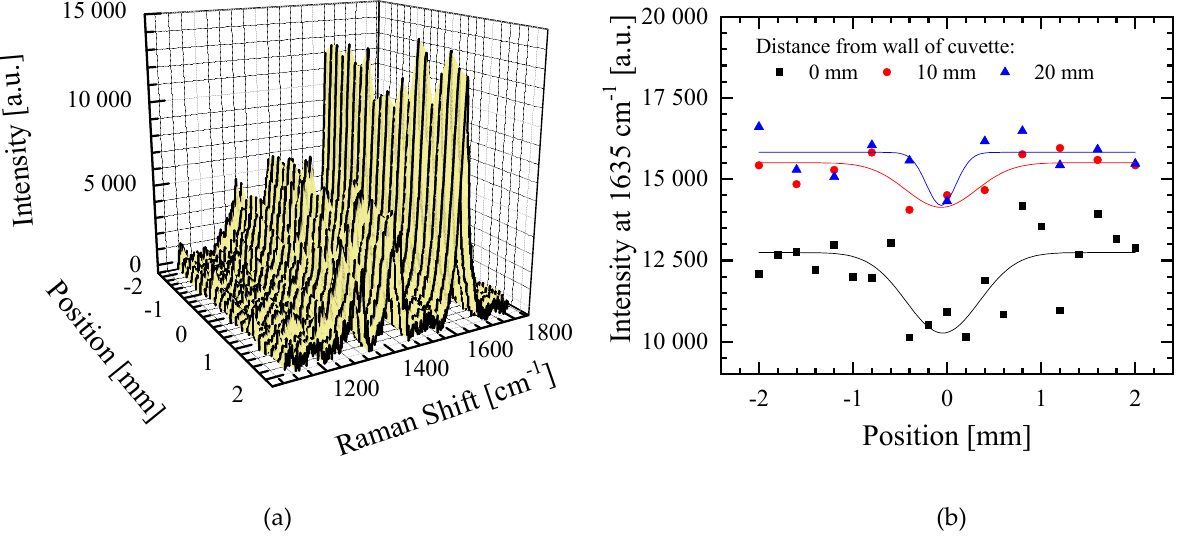
Figure 9. ( a ) Raman spectra recorded along the distance of 4 mm perpendicular to the white line corresponding to polymerized monomer molecules of VIC-T. The spectra start in a non-irradiated region of VIC-T, through green laser light irradiated region to non-irradiated region. ( b ) Intensity profiles of the bands at 1635 cm − 1 versus the positions, where 0 mm denotes the middle of the white line (see Figure 6c) corresponding to the polymerized monomer molecules of VIC-T. The profiles clearly show the area of conversion of monomers into polymer under the influence of irradiation with green laser light–the white line. The profiles obtained were deconvoluted using the Gauss function (Figure 9b). Full width at half maximum (FWHM) was calculated for the profiles to be 0.92, 0.84 and 0.39 mm at the following distances: 0 (near the incident laser beam input), at 10 and 20 mm, respectively. This means that the polymerized area along the white line is the widest near the entrance of the laser beam into the cuvette and narrows at greater distances. This corresponds well to the images showing the high intensity glowing of the VIC-T at shorter distances, which falls at greater distances from the beam entry into the cuvette (Figure 4e,f, Figure 5a and Figure 6b). The reason for this observation is the accumulation of the dose from the laser beam absorbed by the VIC-T at the beam entry into the cuvette due to the continued formation of large macromolecules in the path of the laser light. Growing macromolecules scatter the laser light that is trapped at the beginning of its path in the VIC-T (LLT phenomenon). This boosts the dose from the incident light and scattered light at the beginning of the laser light path, increasing the conversion of VIC-T monomers (widening of the profiles in Figure 9b) and formation of high molecular weight macromolecules that scatter even more laser light. Note that for distances greater than ±~1.1 mm (0 mm profile), ±~0.9 mm (10 mm profile) and ±~0.5 mm (20 mm profile), the intensity of 1635 cm − 1 band increases, which corresponds to a higher concentration of C=C MBA bonds (all the same NVP C=C bonds) and thus a lower conversion to polymer of the vinyl groups outside the green laser light path. In summary, Raman spectroscopy measurements confirmed the LLT phenomenon occurring in the VIC-T dosimeter irradiated with green laser light. Basically, this involves the conversion of VIC-T monomers into high molecular weight polymer macromolecules that scatter the laser light, prevent the laser beam from penetrating the dosimeter, and accumulate the dose of laser radiation near the beam entering the VIC-T dosimeter. It should be noted that Raman analysis showed that the polymerization reaction induced by green laser light was similar to that induced by ionizing radiation [16]. The exact mechanism of polymerization and cross-linking of vinyl monomers specific to 3D gel dosimeters has been studied previously [10,25,26].